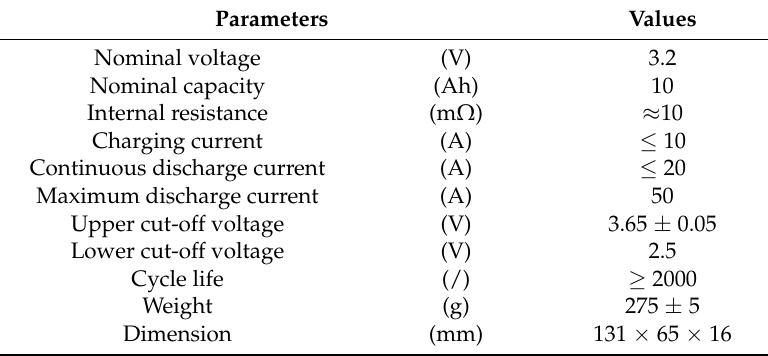
Table 1. Working parameters of lithium